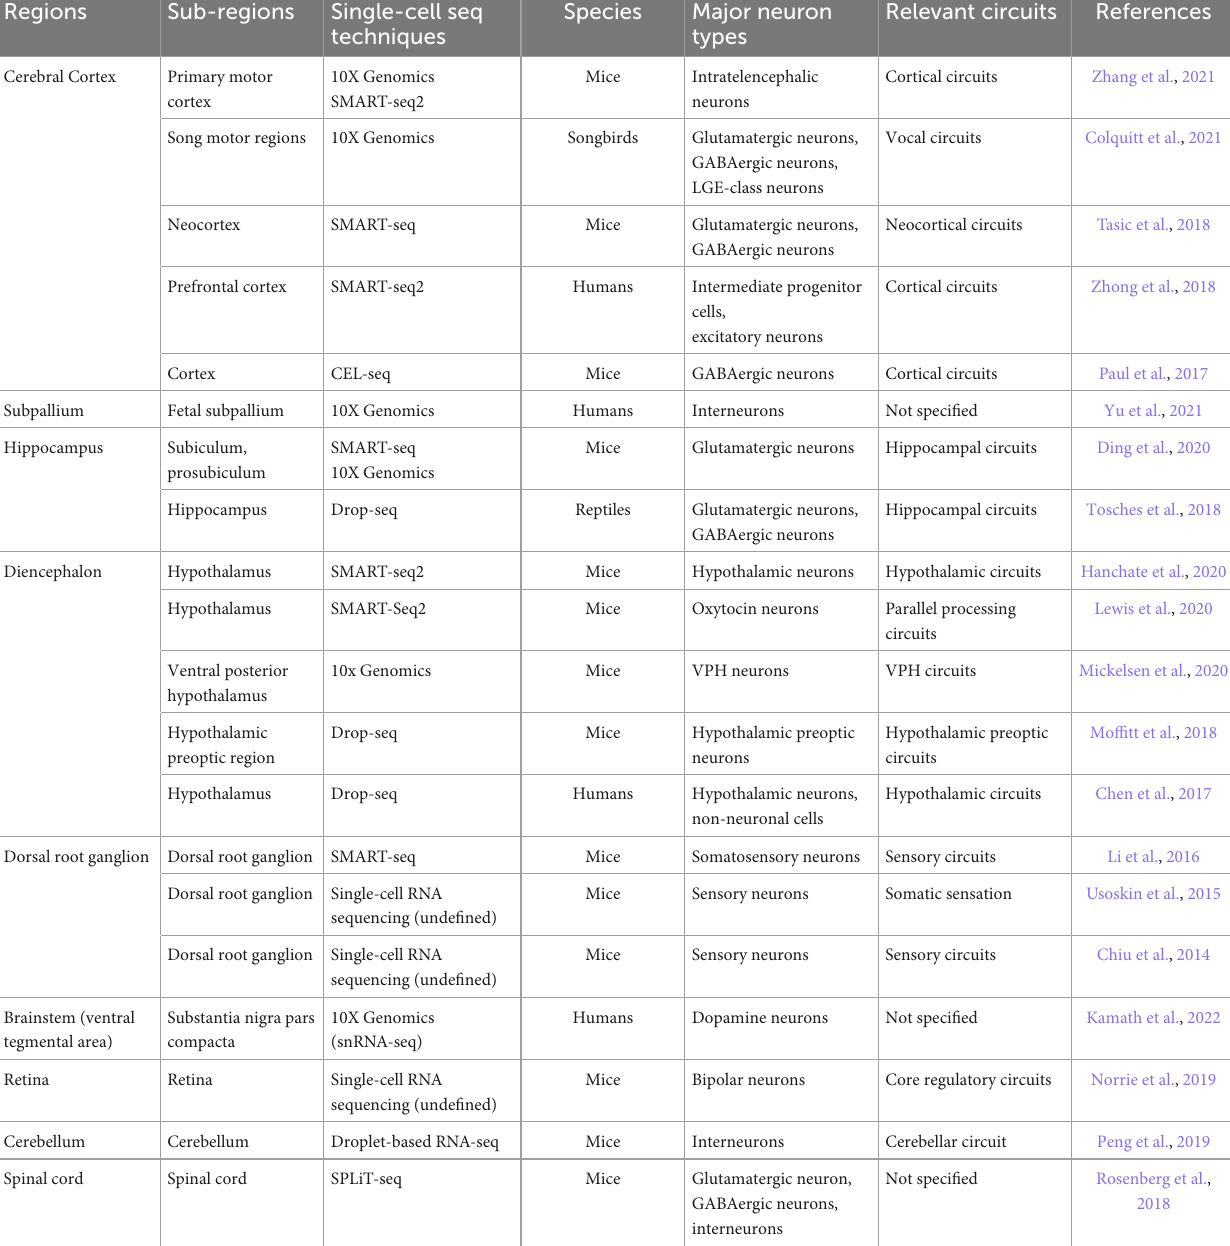
TABLE 2 Examples investigating neuronal diversity and neural circuit complexity across different regions using single-cell